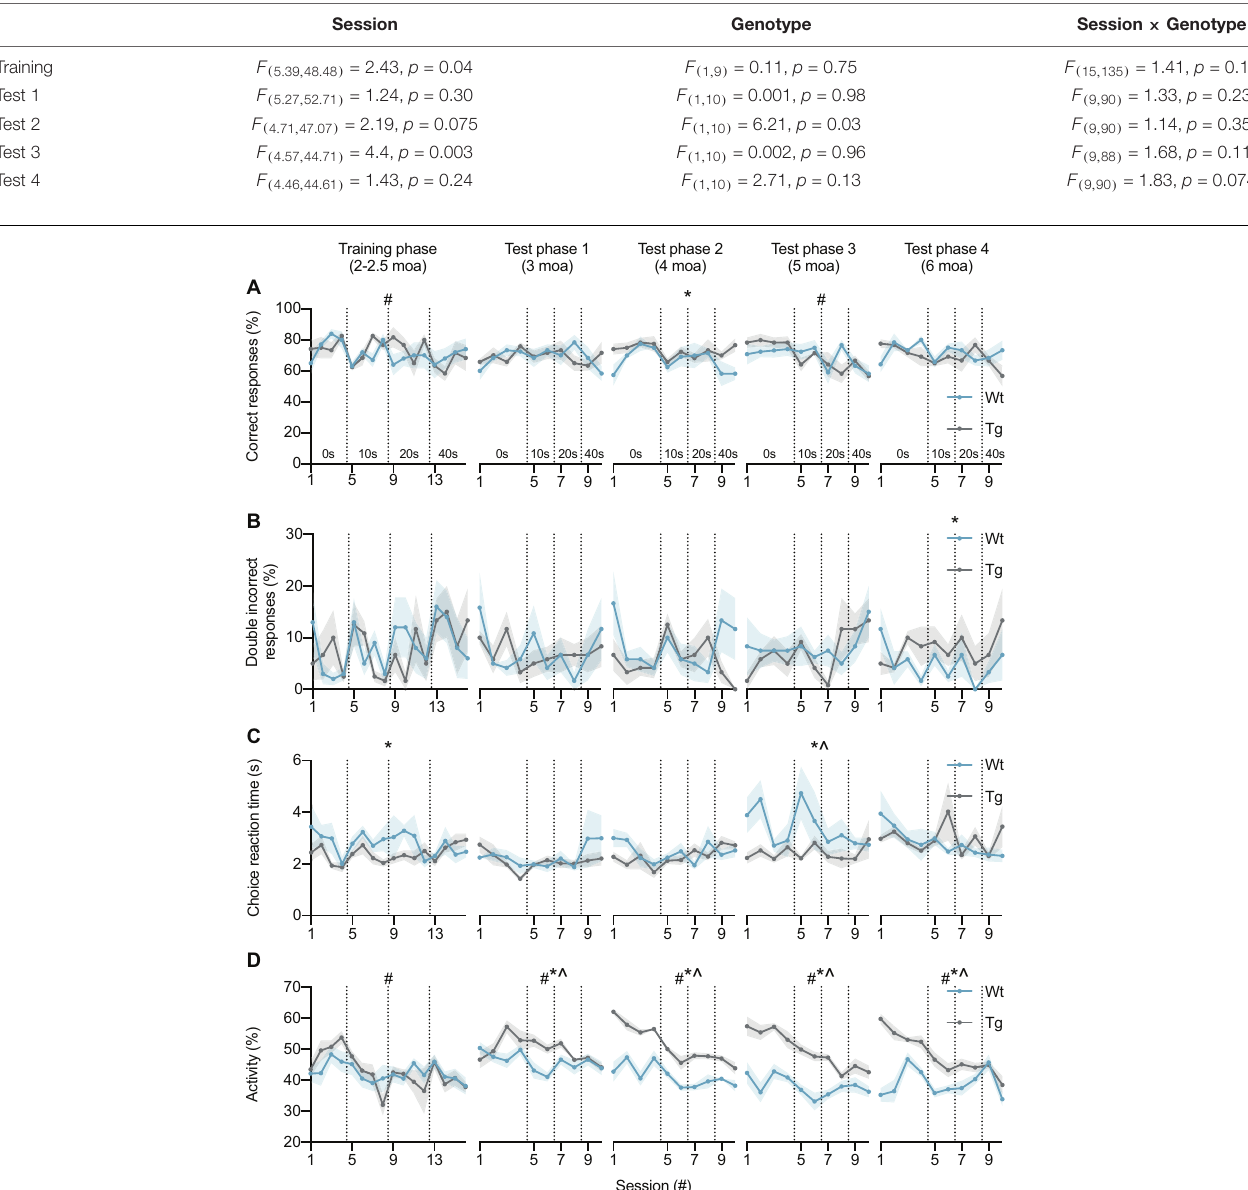
TABLE 1 | Response accuracy.